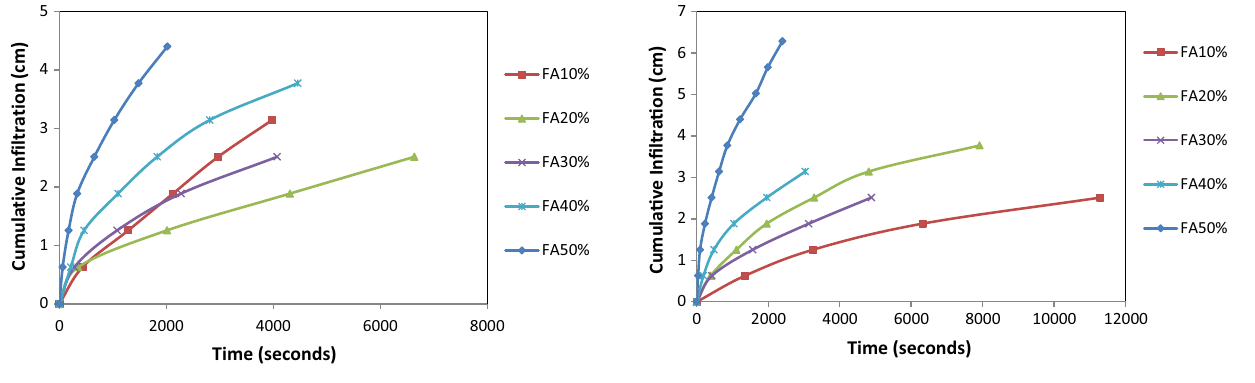
Fig. 6 Cumulative infiltration versus time for varying fly ash at 15% moisture content